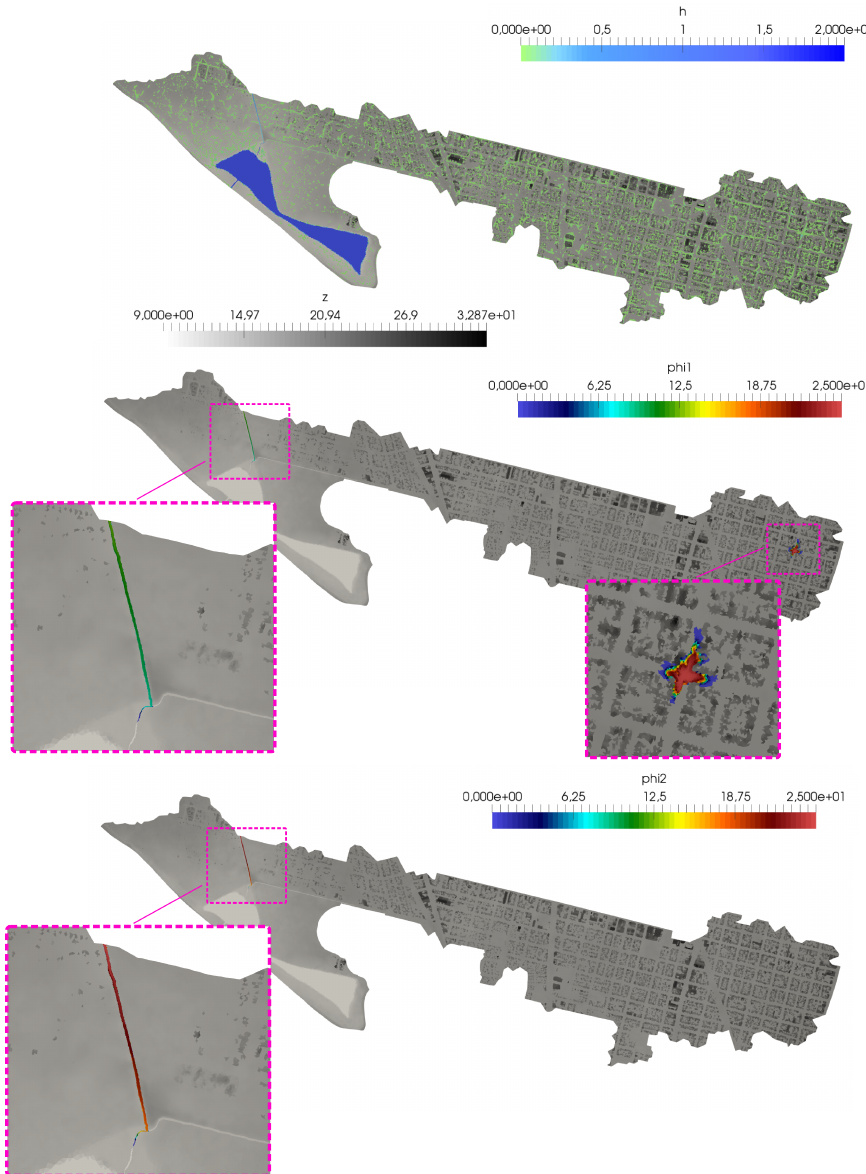
Figure 17. Case 3: Surface water depth h ( upper ) and pollutant concentration for both solutes φ 1 ( center ) and φ 2 ( lower ) at t = 1.1